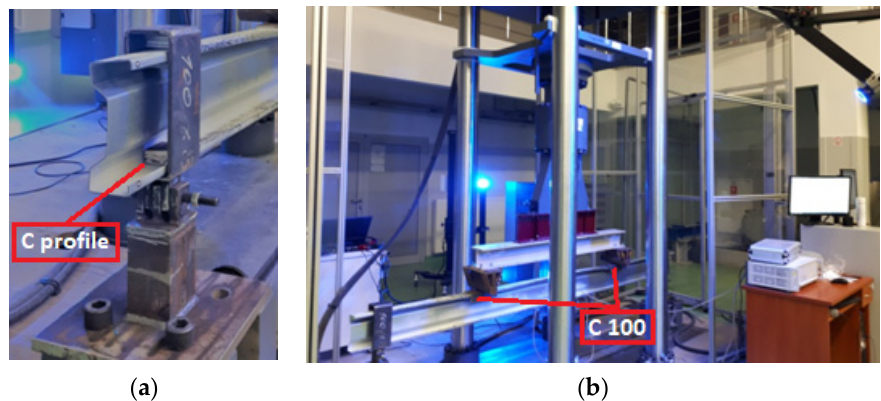
Figure 3. Four-point bending laboratory stand: ( a ) detail of beam support; ( b ) overall view of laboratory stand.